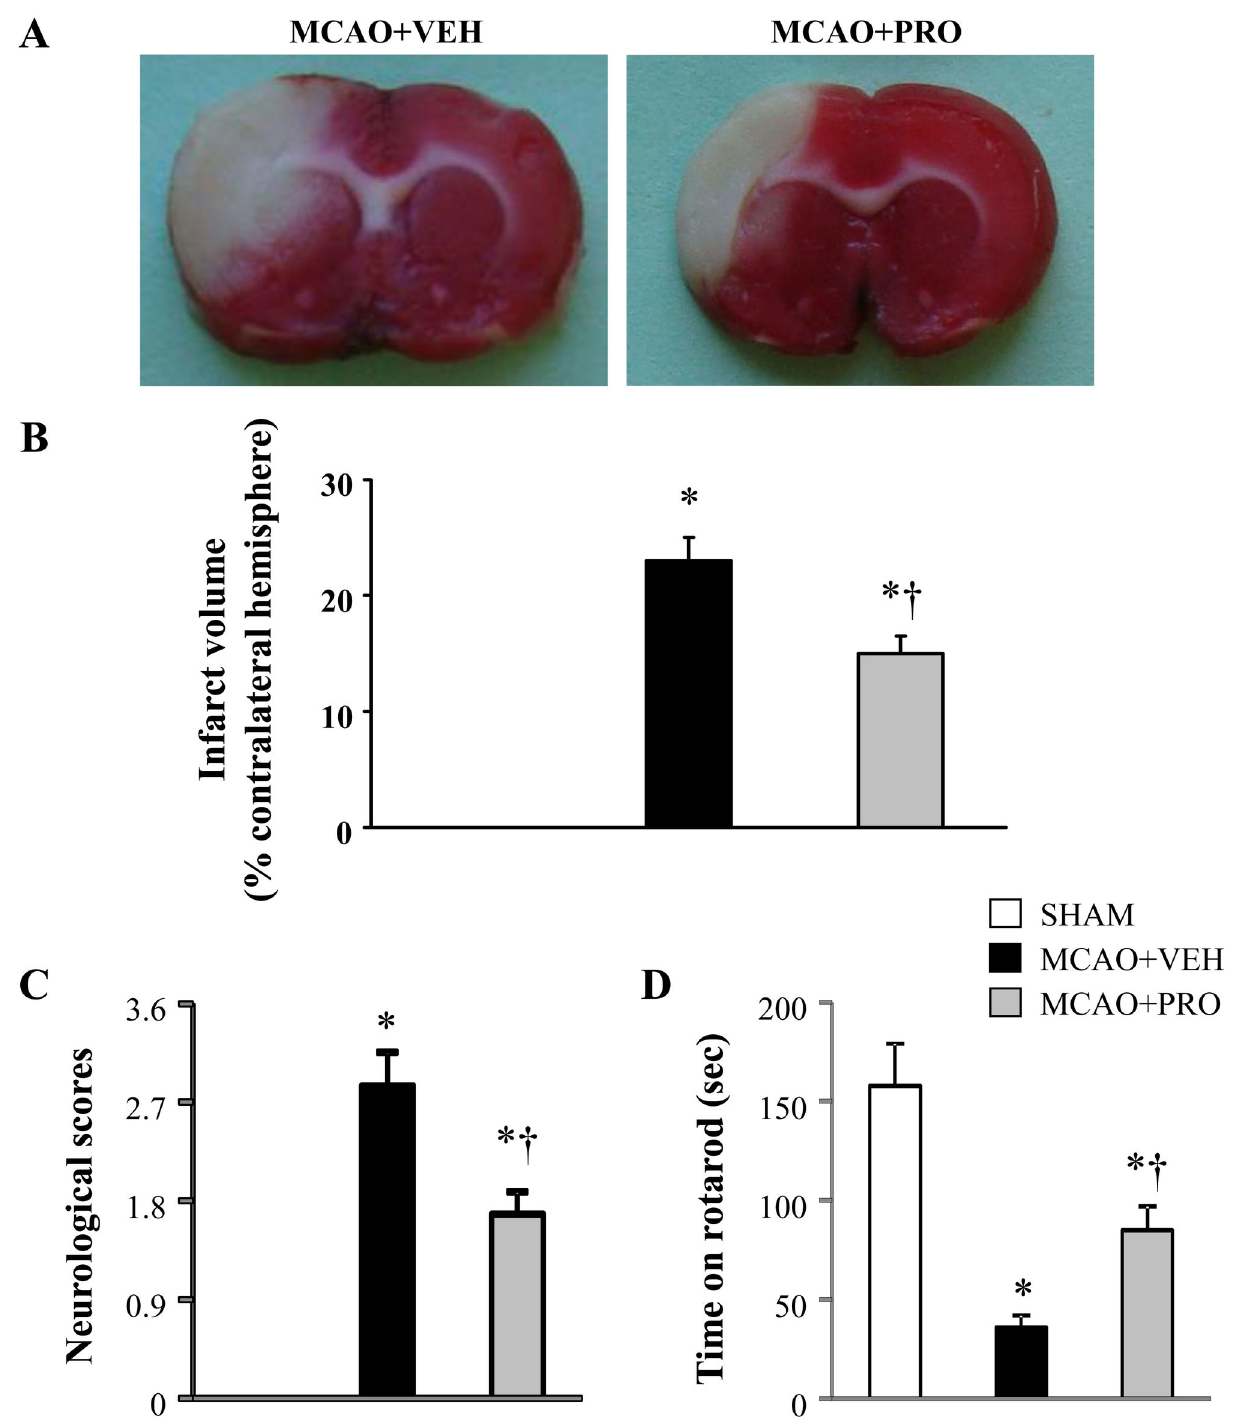
Figure 1. Representative coronal brain slices stained with TTC (A), infarct volume (B), neurological deficit scores (C) and motor coordination (D) 24 h after middle cerebral artery occlusion (MCAO) in rats treated with vehicle (VEH) or propofol (PRO). Sham-operated rats (SHAM) without treatment were used as control. Values are mean ± SEM (n = 8 for each group). * P < 0.05 vs. SHAM, † P < 0.05 MCAO+PRO vs. MCAO+VEH.